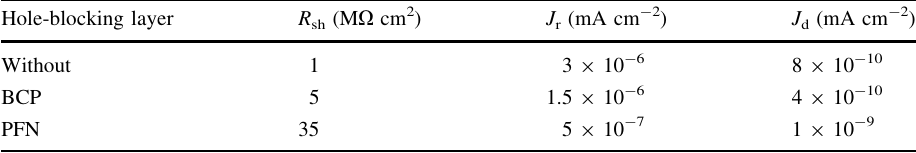
Table 5 R sh , J r , J d derived from fitting dark current of inverted planar PSCs in Fig. 4b